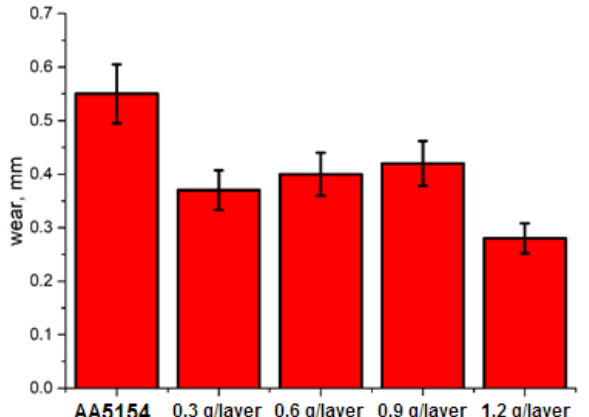
Figure 14. Coefficient of friction vs. time dependencies of samples.